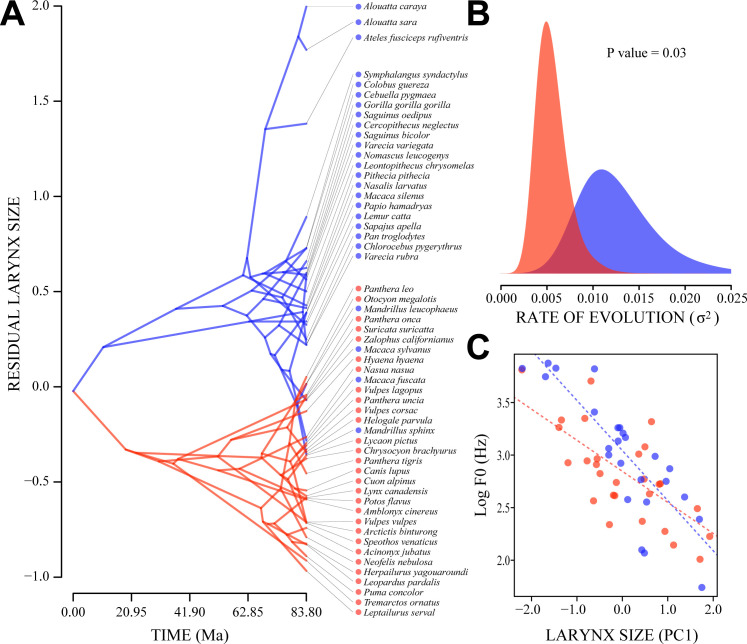
Evolutionary rate analyses.(A) Ancestral phenogram depicting divergence times plotted against residual larynx size from a pGLS regression of larynx size to log body length. Primate lineages (blue) are characterized by larger and more variable values than those of carnivoran lineages (red), as well as faster rates of change. (B) Probability density plots indicating the distributions of evolutionary rates required to produce the variance in residual larynx size observed in primates (blue) and carnivorans (red). The P value is the result of a permutation analysis of primate-to-carnivoran rate ratios (see Methods) and affirms the hypothesis that the two distributions are significantly different. (C) A comparison of larynx size and log mean-F0 in species-typical vocalizations (data from [9]). See S1 Fig for a labeled version of C. The data used to create Fig 4A and 4B are located in S1 Data, sheet B, columns B and C. The data used to create Fig 4C are located in S1 Data, sheet B, columns C and K. F0, fundamental frequency; PC1, first principal component; pGLS, phylogenetic generalized least squares.